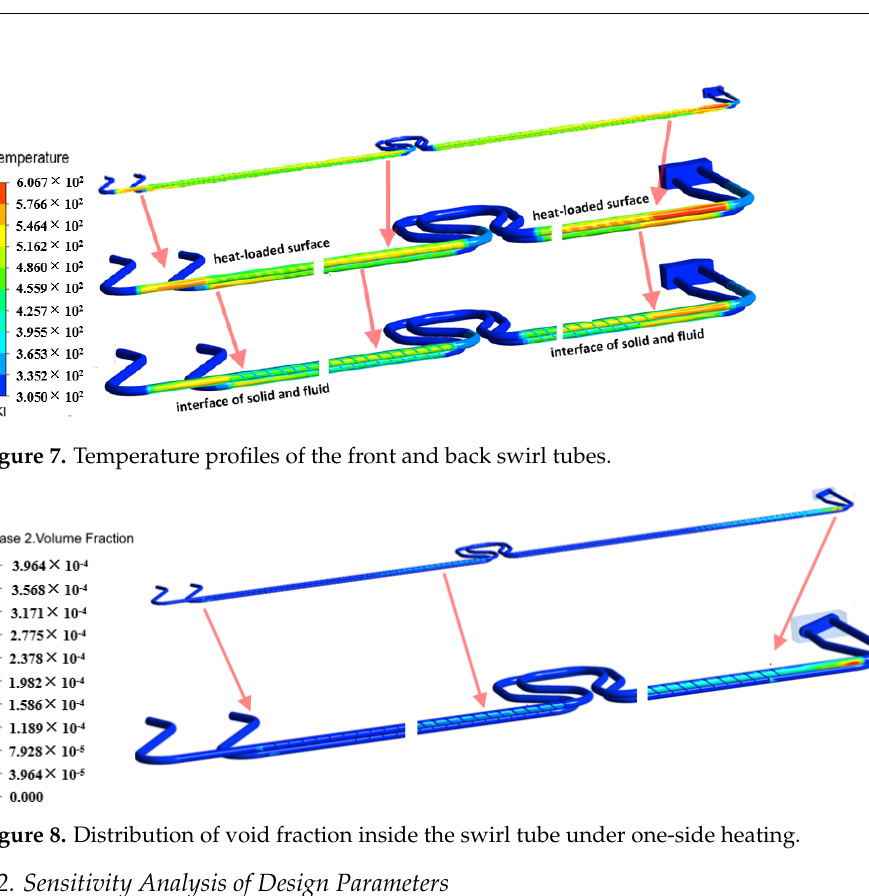
Figure 6. Velocity profile of the front swirl tube.